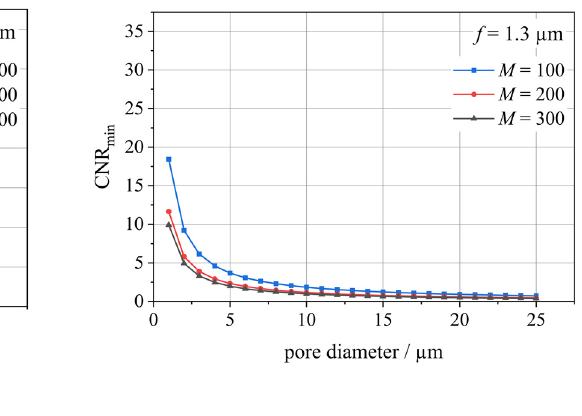
Figure 5. Contrast change as a function of the overlaid profiles of the pore and particle for different particle diameters. C1 is smaller than C2 for the same pore diameter, since the line profile of the larger particle (50 µm) is almost a flat plateau in contrast to the smaller particle.